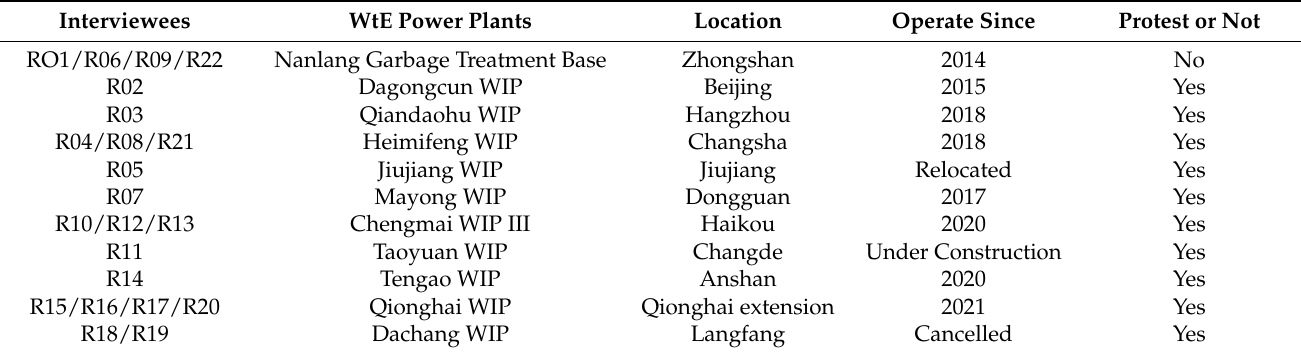
Table 1. Interviewees and WtE Power